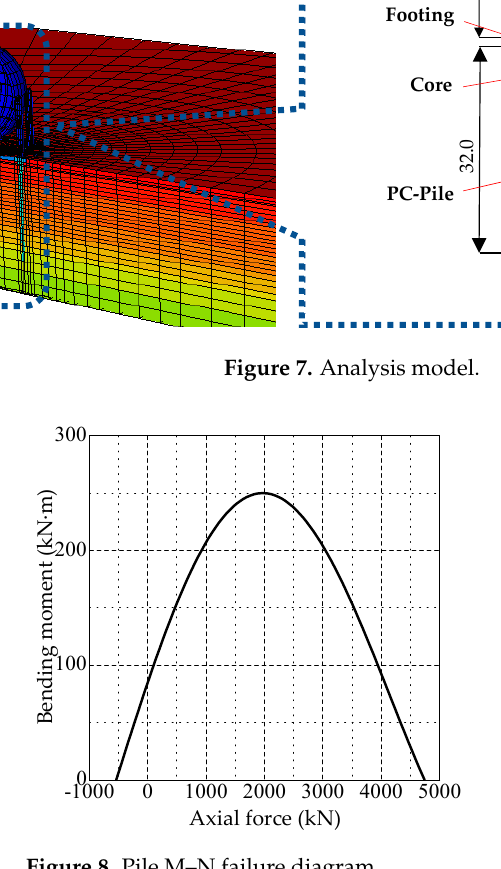
Table 3. Holder foundation/body material constants.